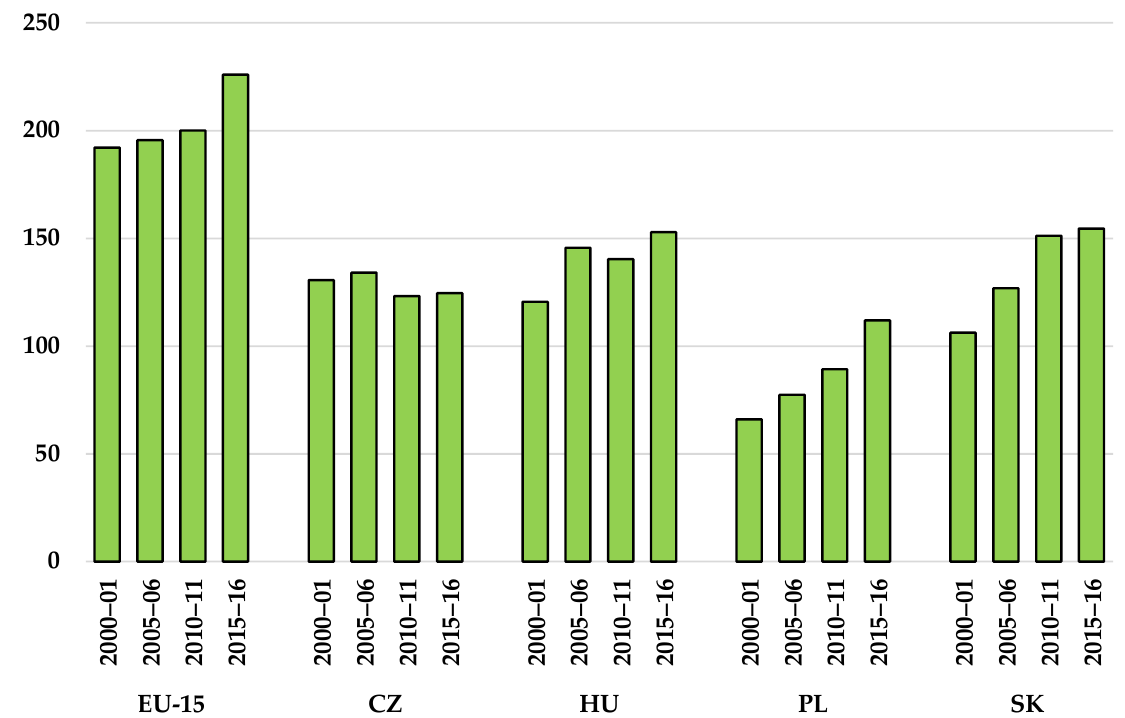
Figure 3. Economic energy efficiency of food production in agriculture (USD in constant prices from 2014-2016/TJ). Source: Own calculations based on WIOD Environmental Accounts and WIOD national input–output tables.